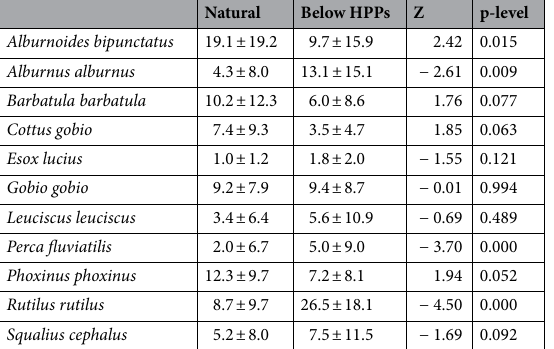
Table 6. Relative abundance (mean ± SD) of common fish species (frequency of occurrence > 50%) in the river stretches with natural flow (n-42) and below HPPs (n-20) and the significance of their differences (Mann– Whitney U